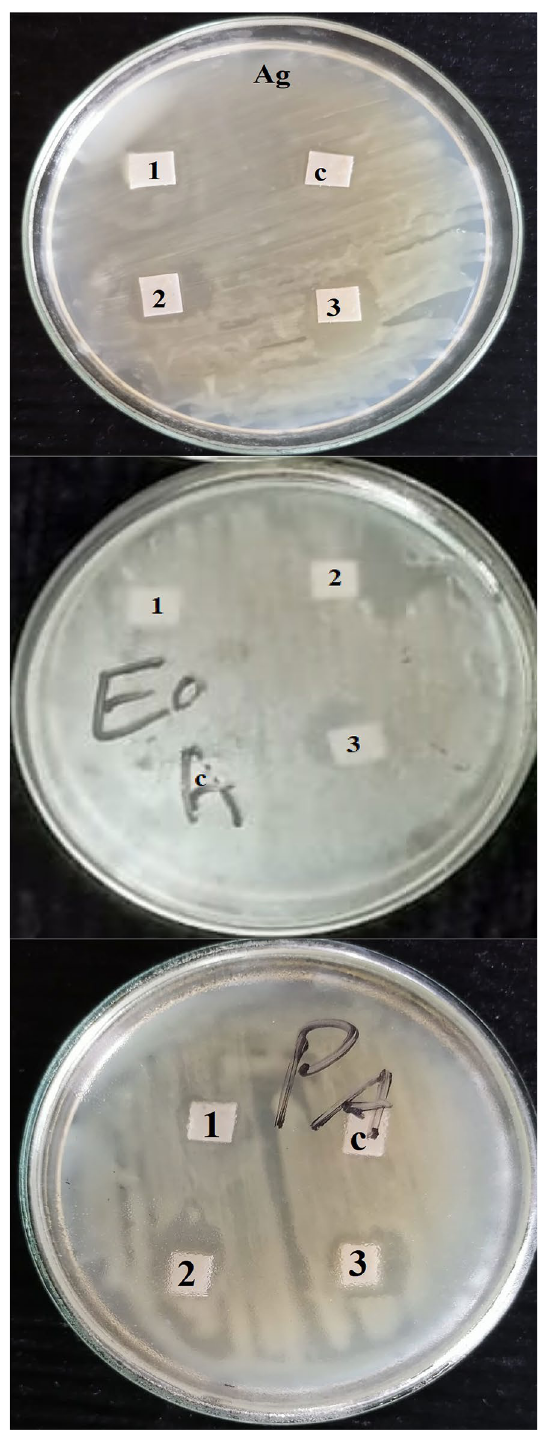
Figure 5. Antibacterial activity of treated papersheet discs with M. oleifera SRRP extract against (Ag) Agrobacterium tumefaciens ; (Ea) Erwinia amylovora ; (PA) Pectobacterium atrosepticum . c : Control; 1: Extract concentration 1000 µg/mL; 2: Extract concentration 2000 µg/mL; 3: Extract concentration 4000